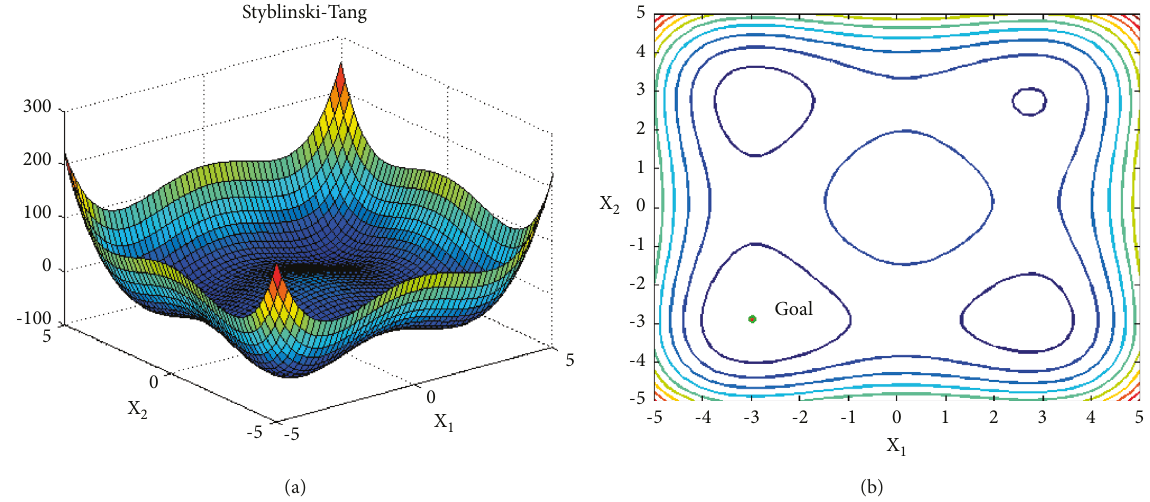
Figure 4: The Styblinski–Tang function: (a) The shape of the 3 dimensions; (b) The contour. Table 1: Parameter setting of the hybrid algorithm.